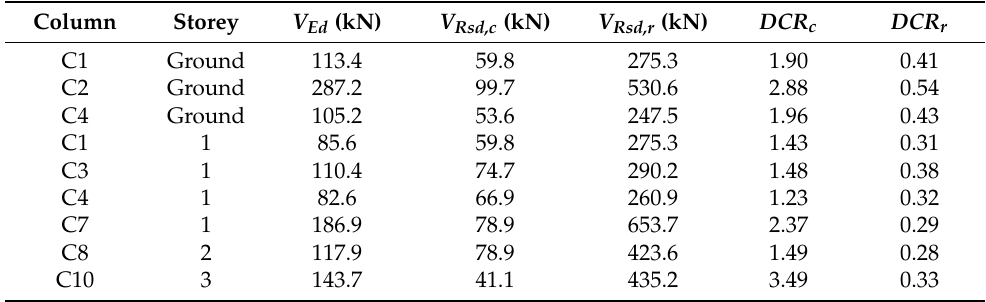
Table 3. Shear demand, capacity values in current and retrofitted conditions, and relevant de- mand/capacity DCR ratios–selected columns.